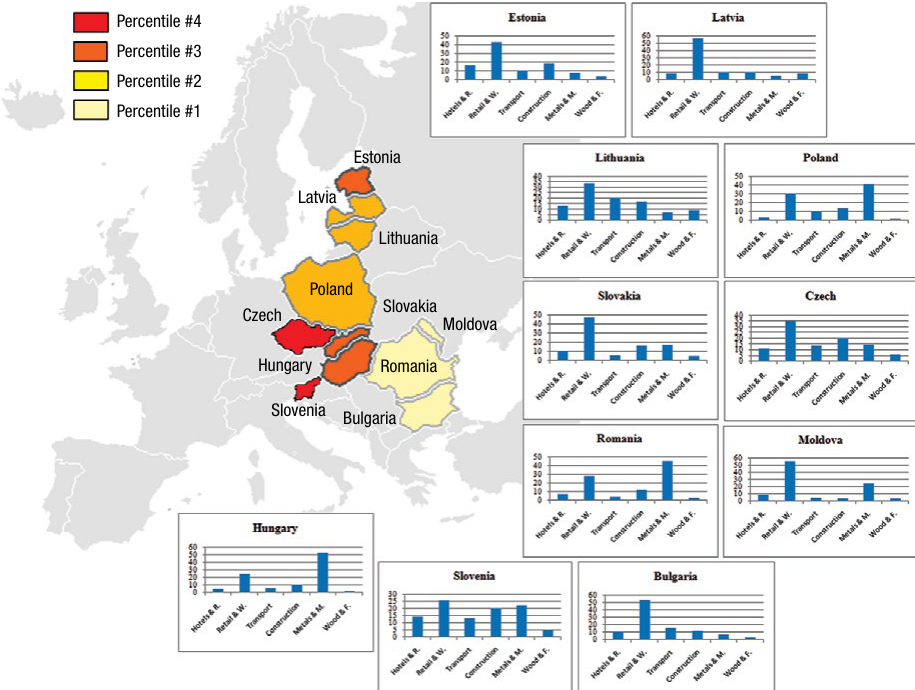
Fig. 1. GDP per capita according to percentile and representative percentage of firms by sector and